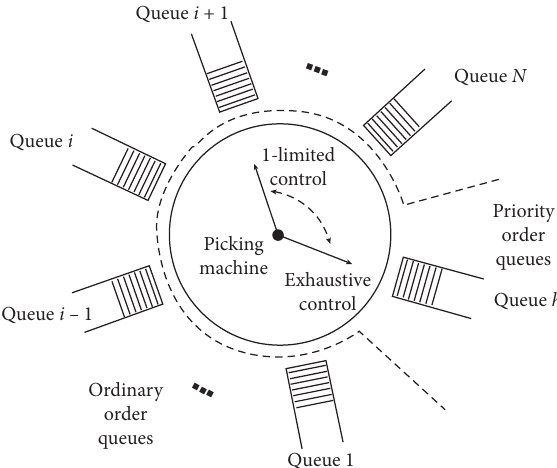
Figure 1: The “exhaustive parallel 1-limited” based picking